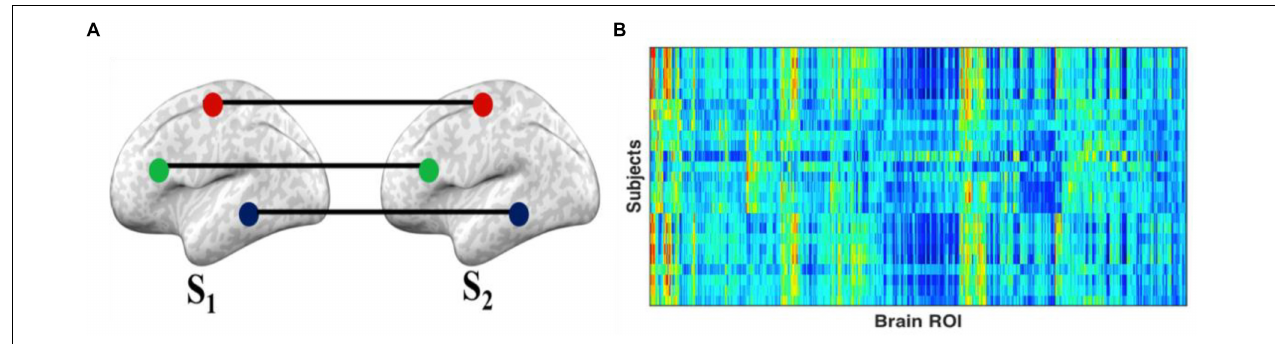
FIGURE 1 | Intersubject correlation (ISC): (A) ISC is the correlation of the activity of the same region of interest across all subjects. The ISC is estimated by the correlation of each subject’s (S 1 ) ROI time series and the average ROI time series of all other subjects (S 2 ... S N ). (B) The final results can be represented in a matrix with rows representing subjects and columns representing ROIs, with the cells containing the ISC of each ROI for each subject.